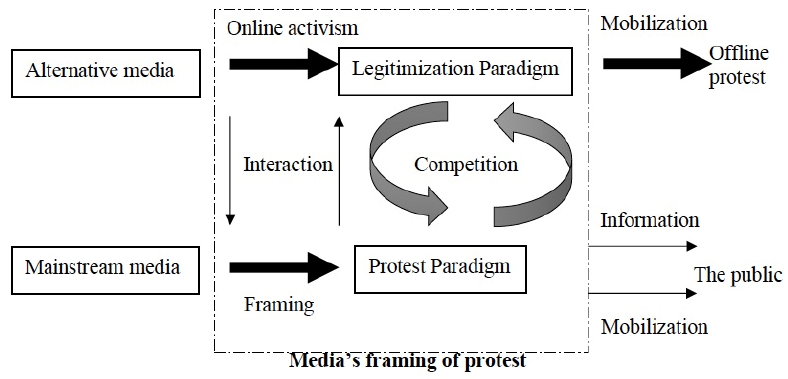
Figure 4. Media’s framing of a social-media-driven protest.